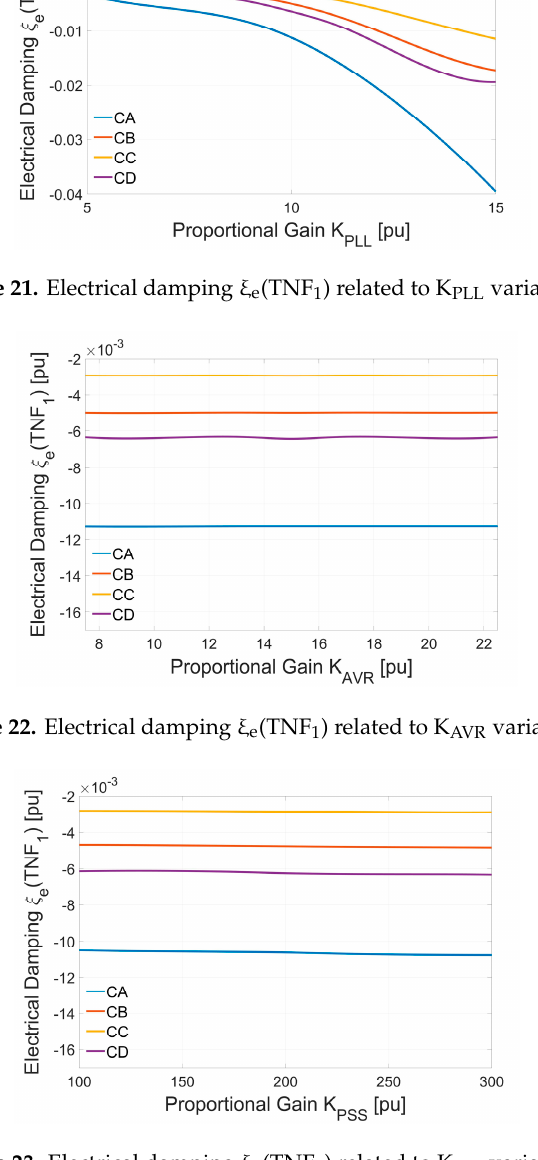
Figure 22. Electrical damping ξ e (TNF 1 ) related to K AVR variations. Figure 24. Sensitivity coefficient of electrical damping ξ e (TNF 1 ) related to K PI .